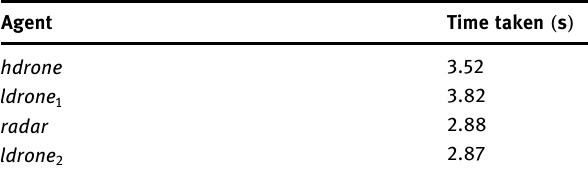
Table A1: Time taken for